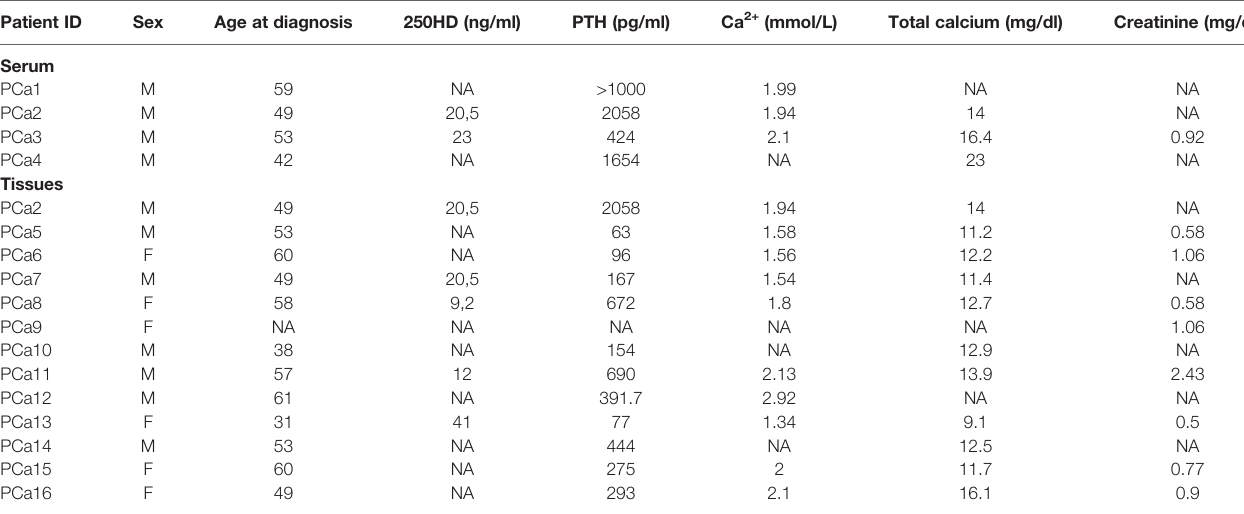
TABLE 2 | Clinical and biochemical data of parathyroid carcinomas.